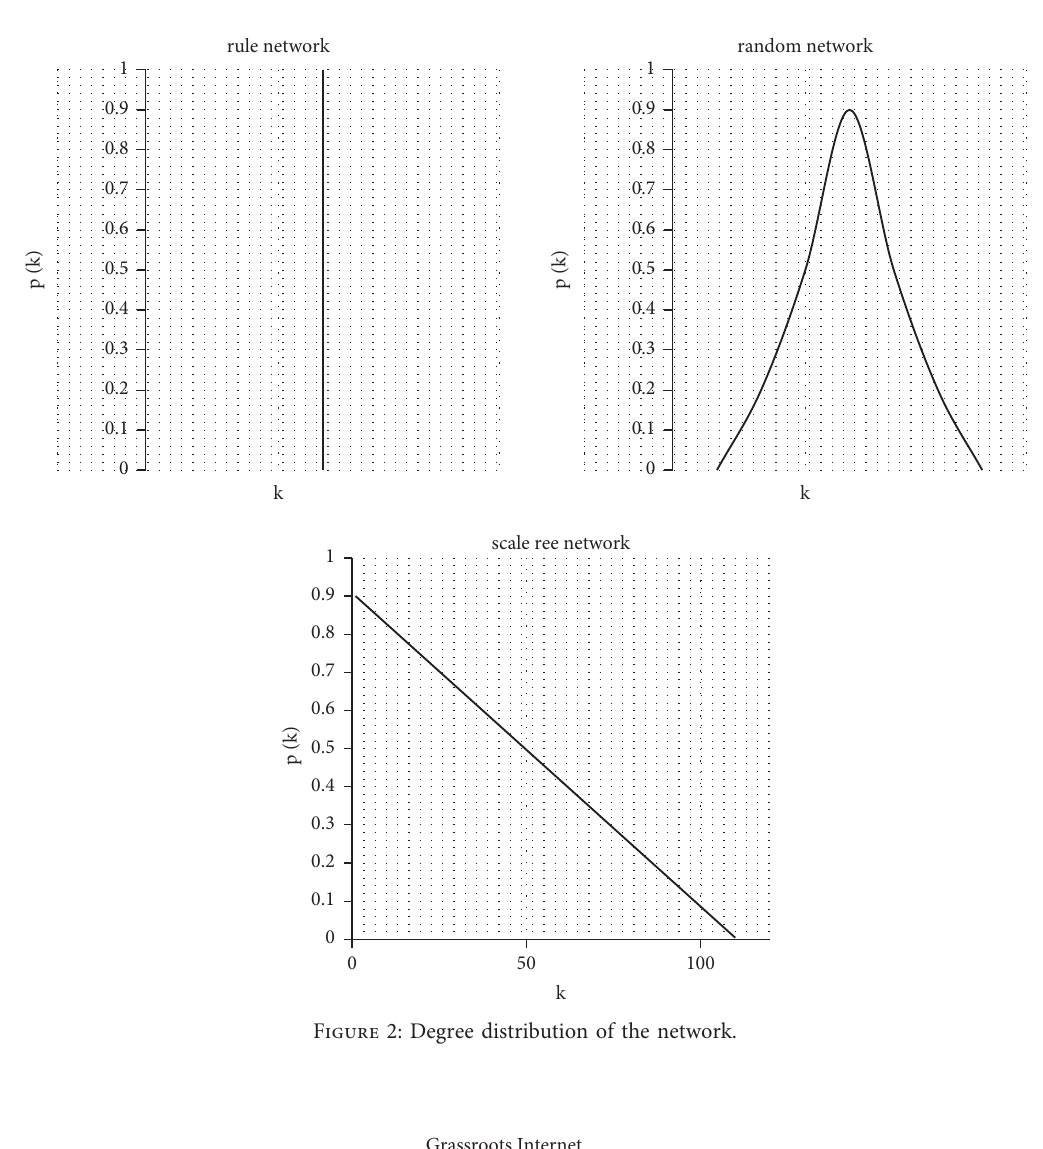
Figure 2: Degree distribution of the network.